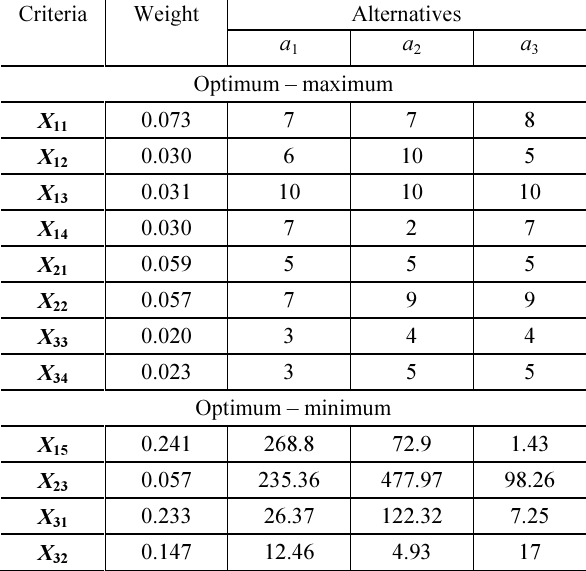
Table 4. Initial decision-making matrix Criteria